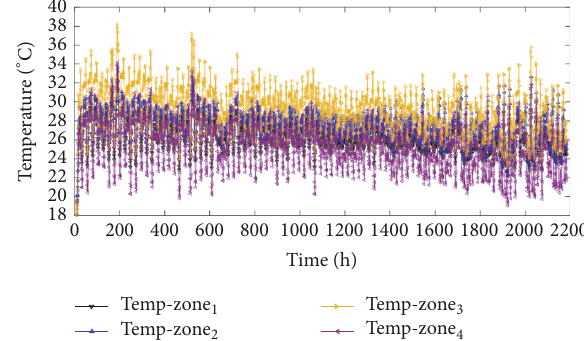
Figure 10: Actual data of return air CO 2 levels of the building for each AHU.